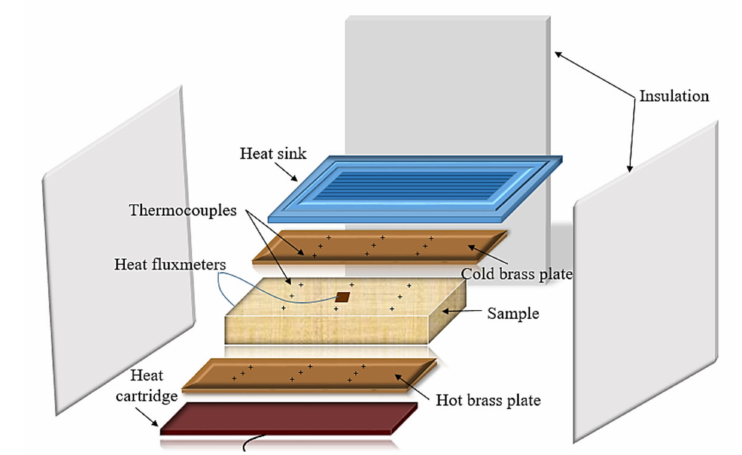
Figure 3. Experimental set up.